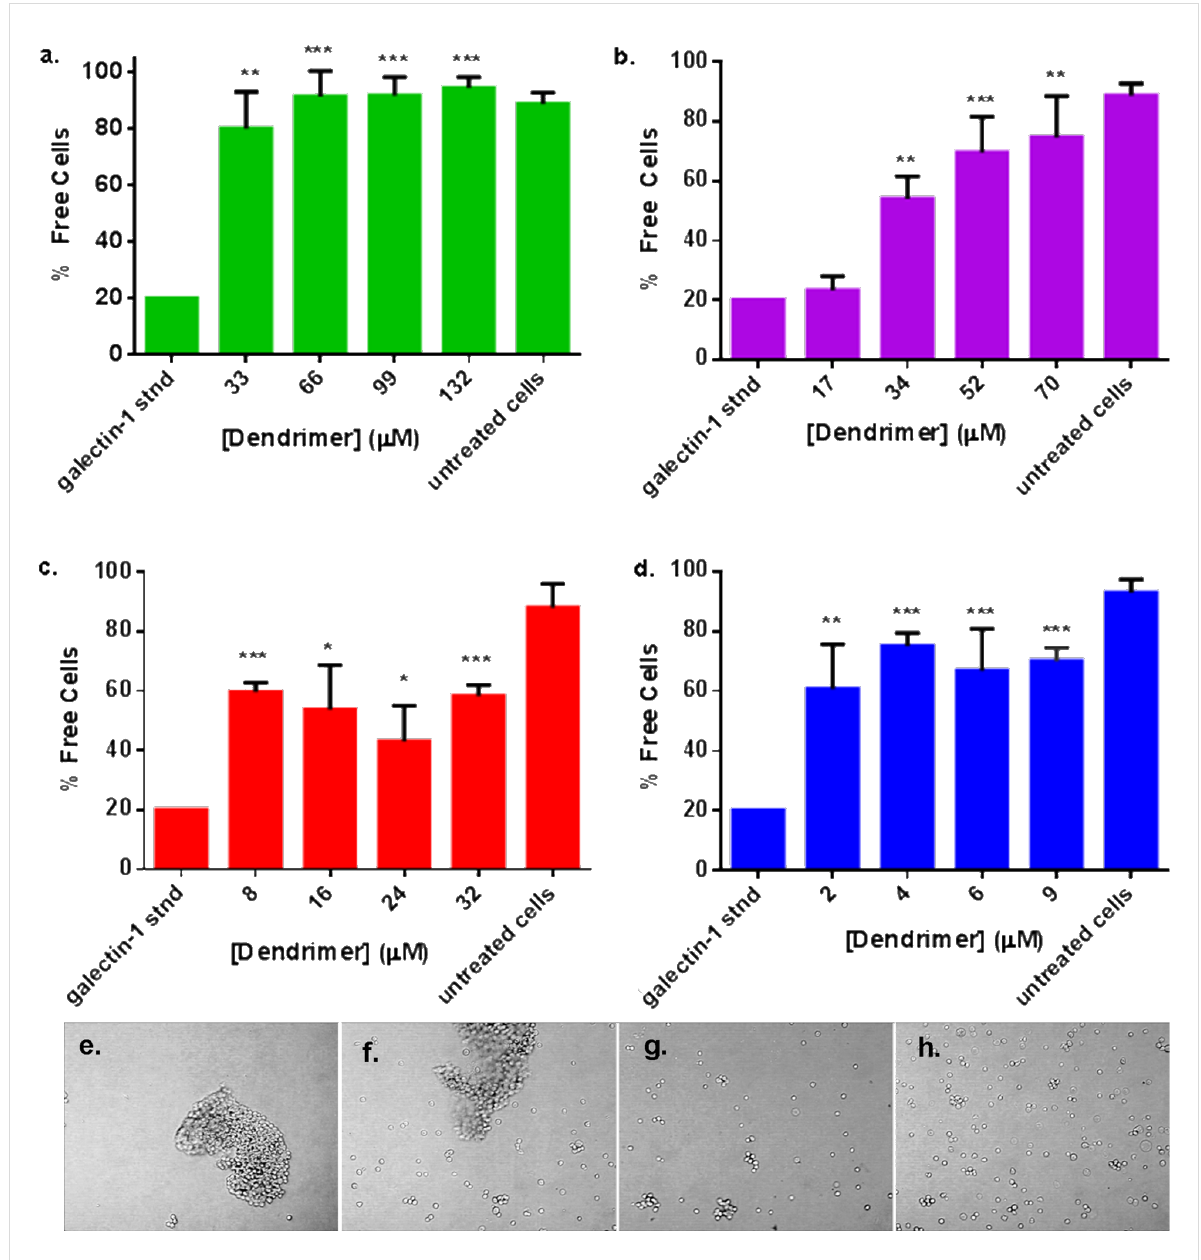
Figure 7: Cellular aggregation assays with DU145 human prostate carcinoma cells. Cancer cell aggregation assays were performed in the presence of 3.7 µM galectin-1 and increasing glycoderdrimer concentrations, with controls for galectin-1 treated cells and untreated cells. Glycodendrimer concentrations were normalized to present the same concentration of lactose residues. The results show inhibition of galectin-1 induced aggregation by (a) 1, (b) 2 , (c) 3 , and (d) 4 . Data are shown as mean ± S.D. of measurements from at least three experiments. Statistical analysis was performed using an unpaired two-tailed student’s T-Test by comparing the % free cells to the galectin-1 standard and * indicates p value < 0.05, ** indicates p < 0.01, and *** indicates p < 0.001, representative images of cellular aggregation are provided for DU145 with 3.7 µM galectin-1 and: (e) 17 µM 2 ; (f) 34 µM 2 ; (g) 52 µM 2 ; and (h) 70 µM 2 .